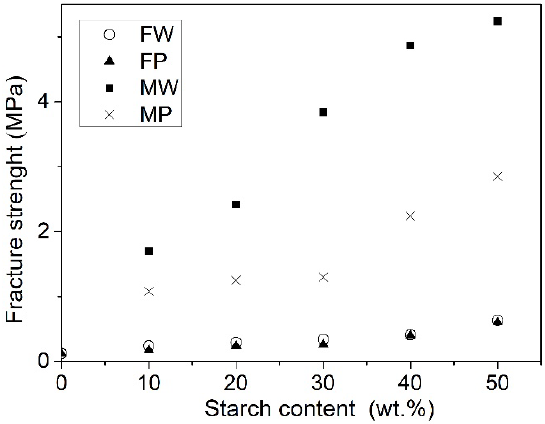
Figure 7 . Dependence of the fracture strength from the composition of the carbon precursor .